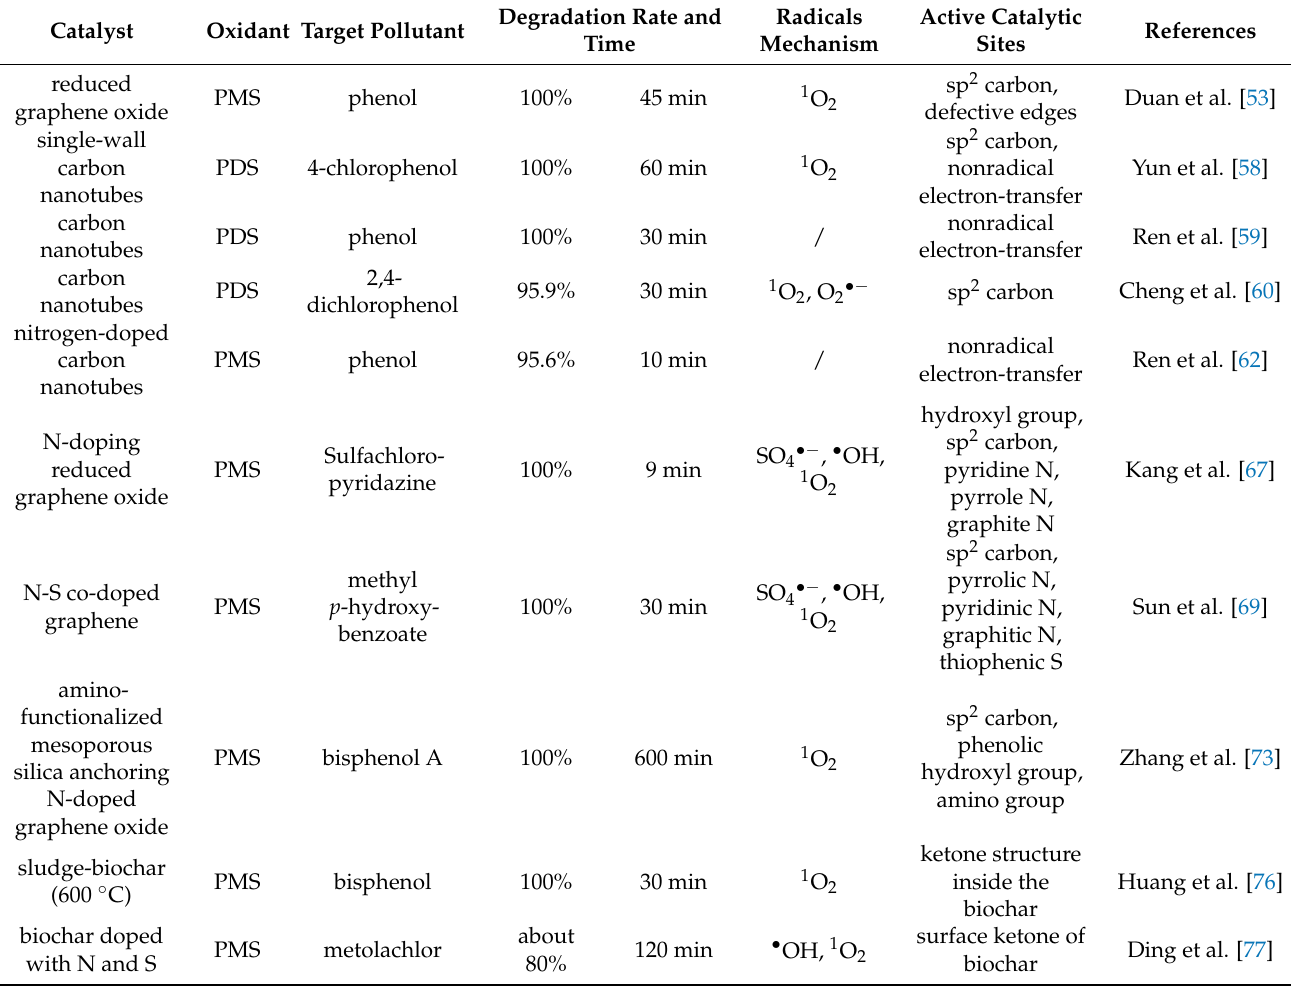
Table 2. Performance and mechanism of typical MFCMs catalysts for PDS/PMS oxidation of pollutants.